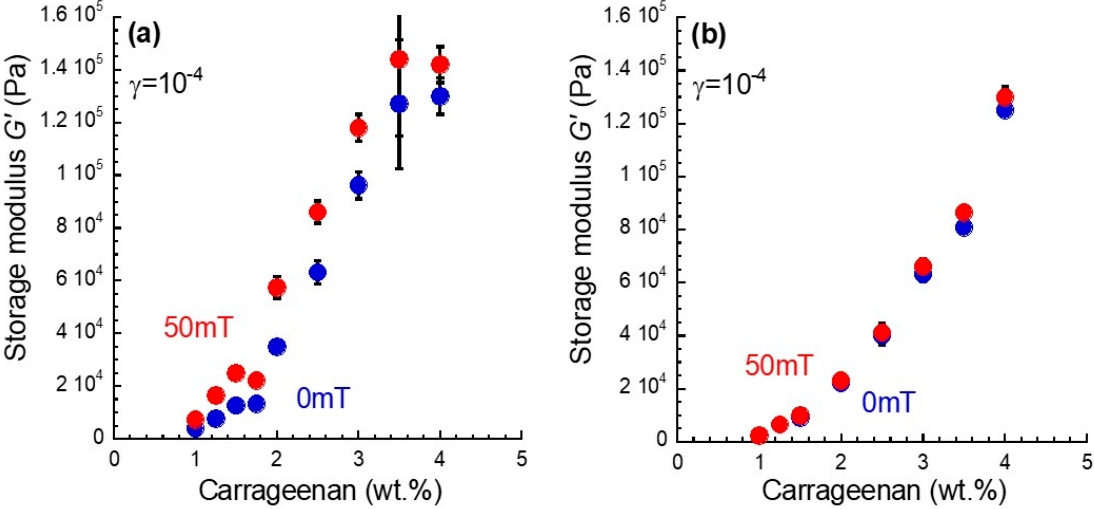
Figure 2. The carrageenan concentration dependence of the storage moduli at 0 mT and 50 mT for ( a ) magnetic gels with a concentration of 50 wt.% and ( b ) carrageenan gels without magnetic parti- cles.